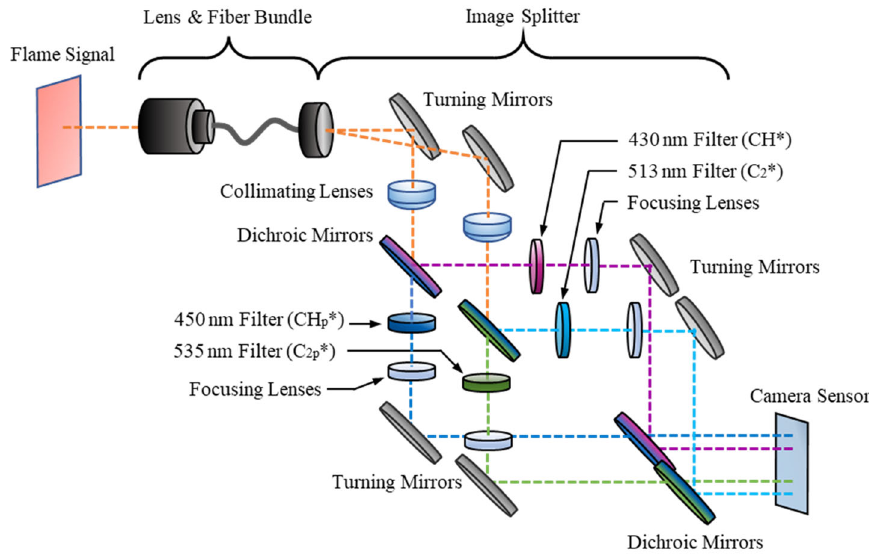
Figure 2. Schematic representation of optical components for four-line chemiluminescence imaging.